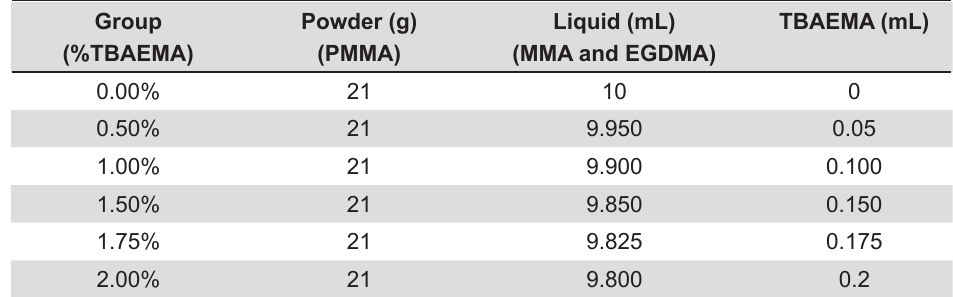
Table 1- Groups evaluated in the study, according to the proportion of powder, liquid and TBAEMA